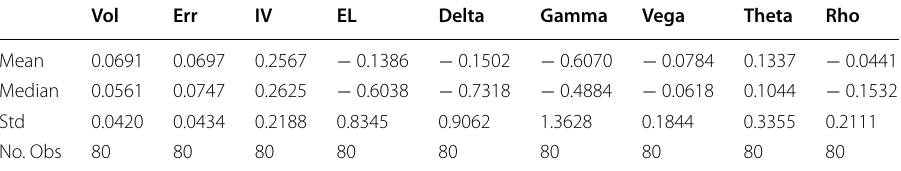
Table 5 Summary statistics of option